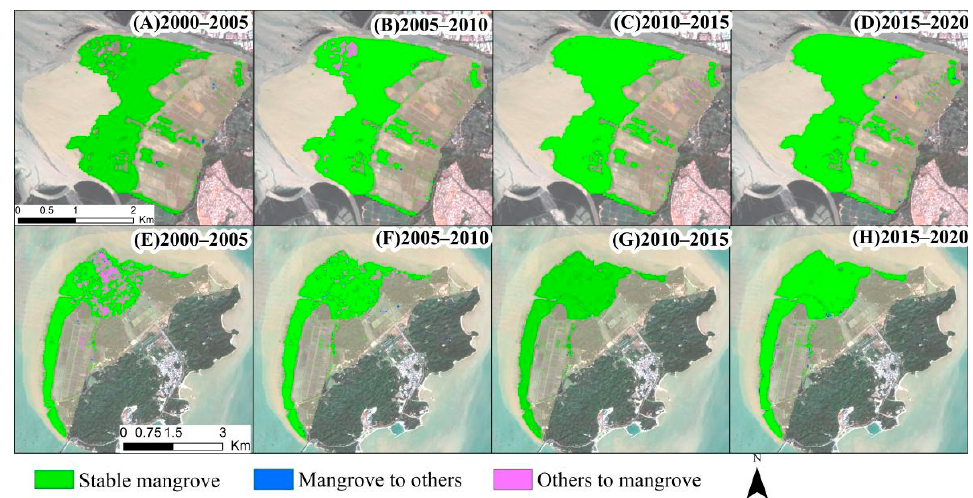
Figure 6. Mangrove gain and loss in nature reserves every five years from 2000 to 2020. The MPMNR is on the top and the QIMNR is on the below. ( A , E ): 2000–2005, ( B , F ): 2005–2010, ( C , G ): 2010–2015, ( D , H ): 2015–2020.